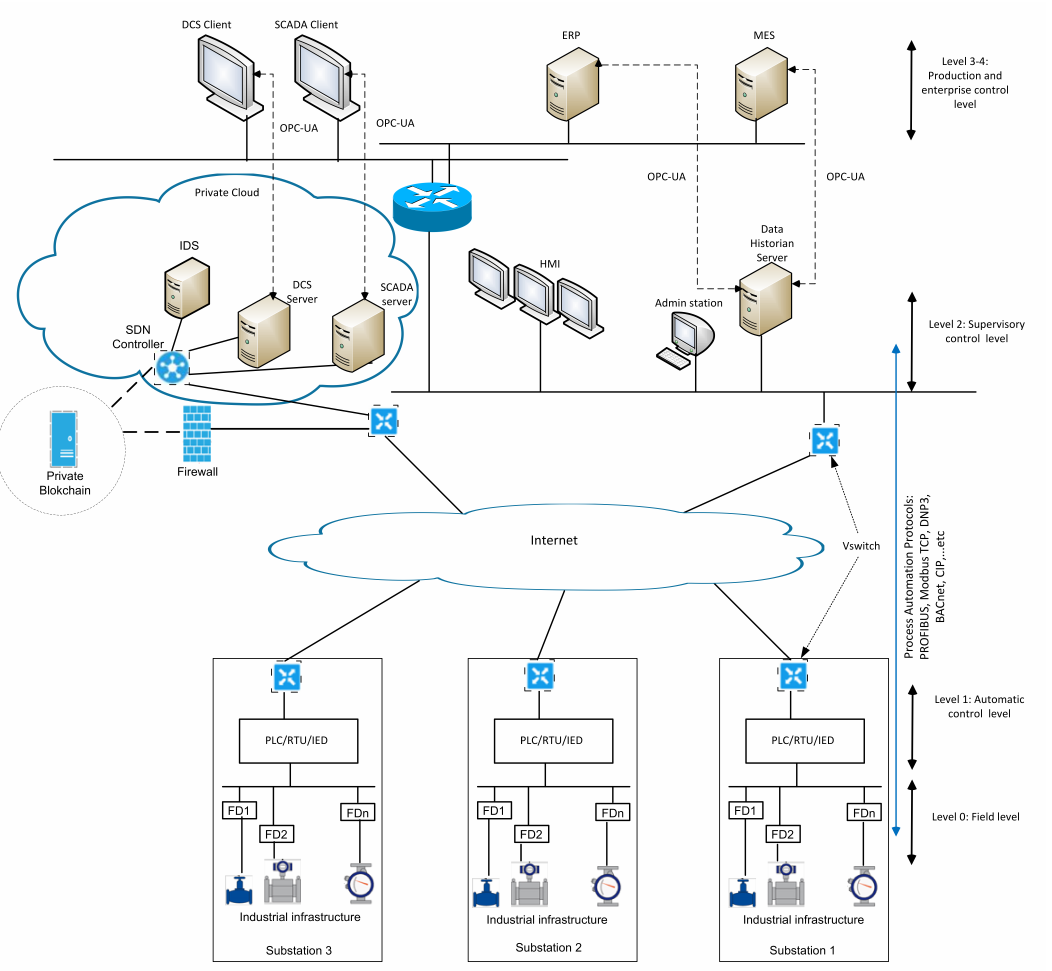
Figure 3. Security architecture for SDN-based